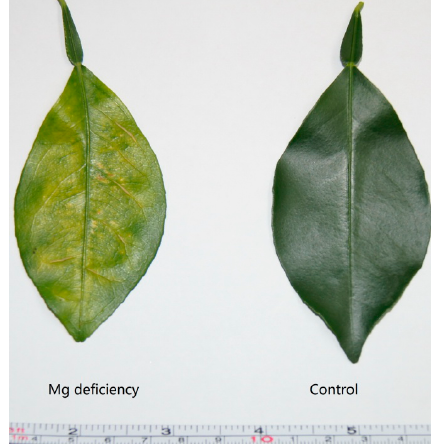
Figure 1. Symptom of Mg deficiency in C. sinensis leaf.